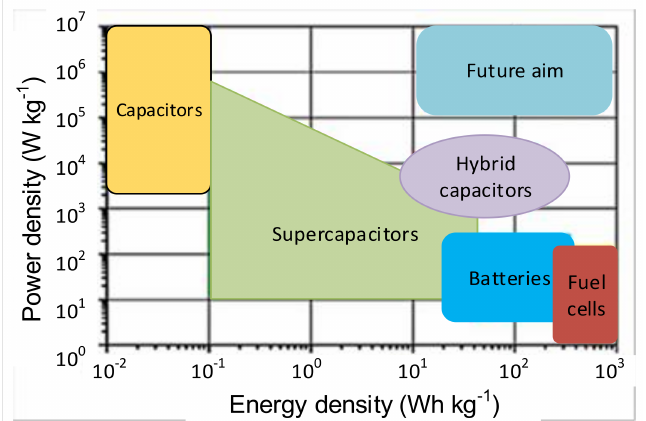
Figure 2. Comparison of the energy and power density of storage devices